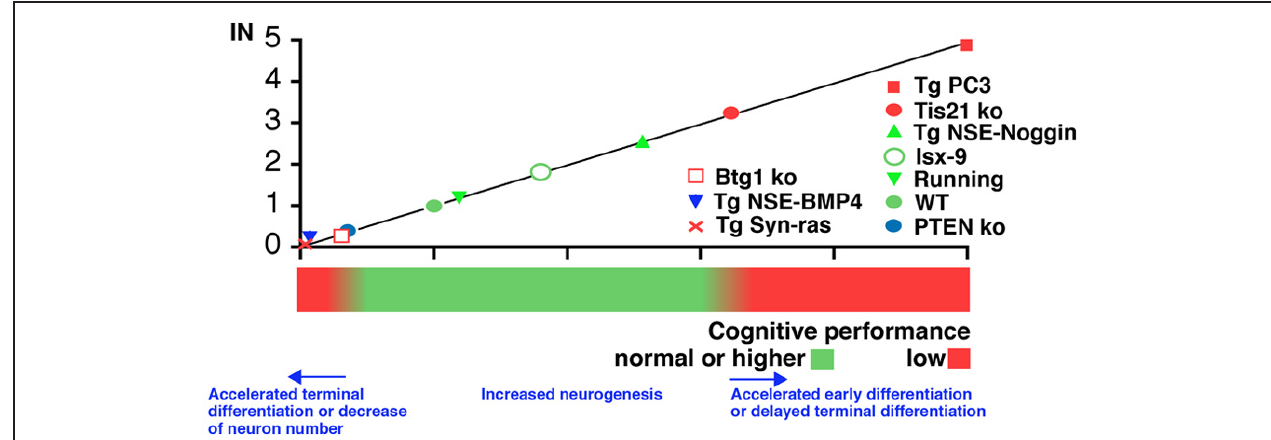
FIGURE 2 | Correlation between IN (neurogenesis index in the dentate gyrus) and hippocampus-dependent cognitive performance in situations of altered neurogenesis. IN was calculated as described in the text for the conditions of altered neurogenesis observed in the mouse model Tg PC3/Tis21 (accelerated differentiation without change in neuron number), or in PC3/Tis21 and Btg1 knockout mice (impaired terminal differentiation, or reduced number of neurons generated, respectively). Additional mouse models were tested for their correlation with the proposed models: Tg